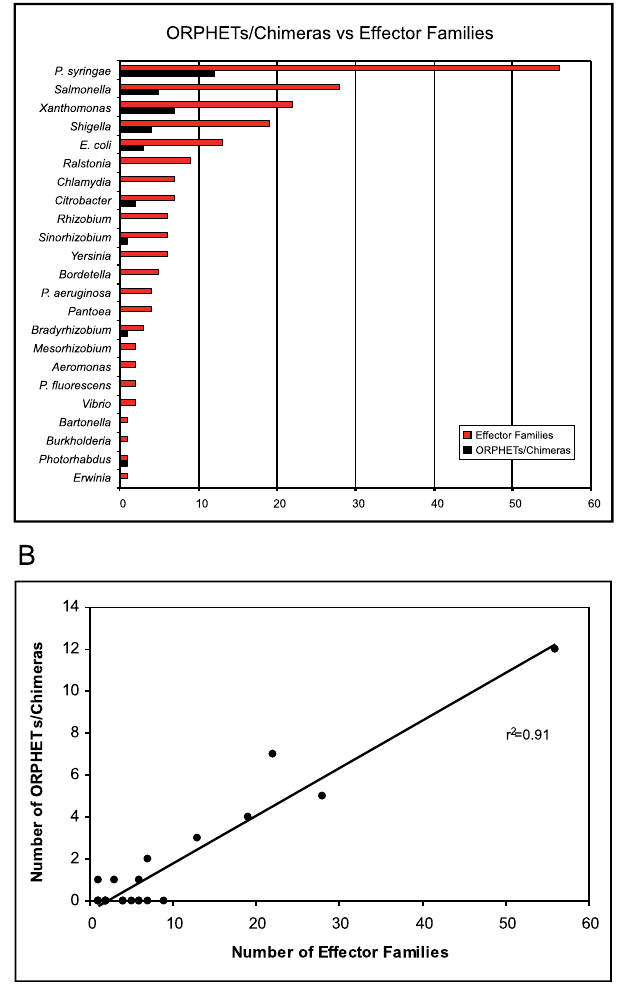
Figure 4. Frequency of ORPHETs and Chimeras among Bacterial Pathogens (A) Histogram illustrating the number of effector families analyzed for each species and the number of ORPHETs/chimeras identified for each. (B) Regression analysis of the number of effector families versus the number of ORPHETs/chimeras identified for each given species, r 2 ¼ 0.91. DOI: